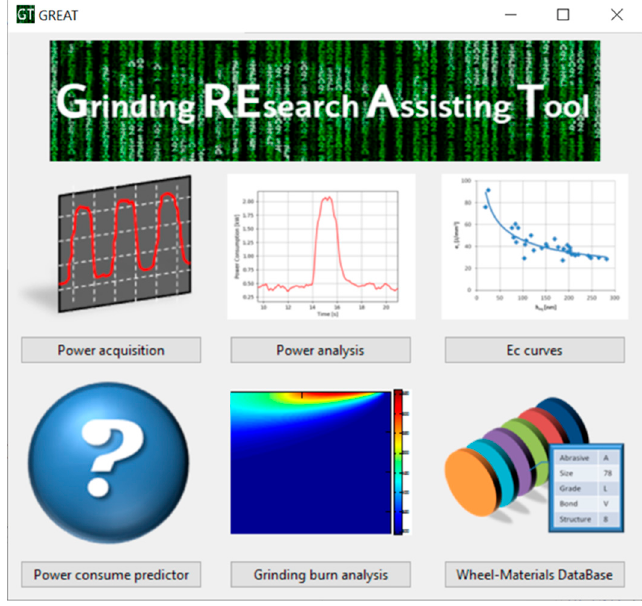
Figure 4. Layer 4: The Grinding Research Assisting Tool (GREAT).